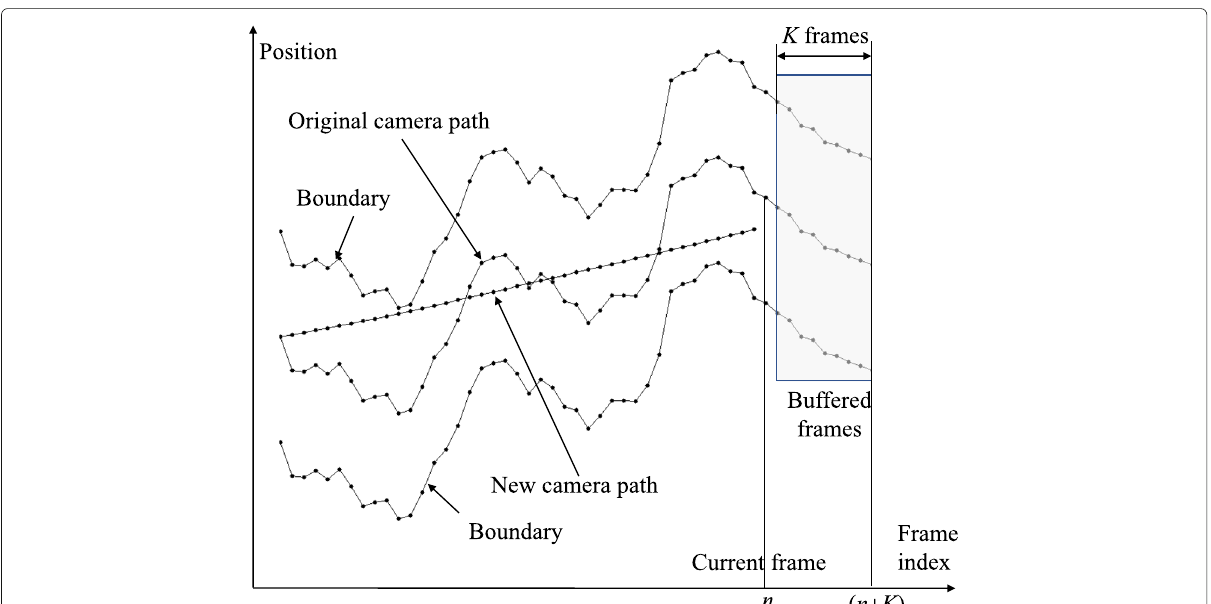
Fig. 5 The goal of the proposed algorithm is to provide a novel camera path under that the original camera positions for the next available K frames